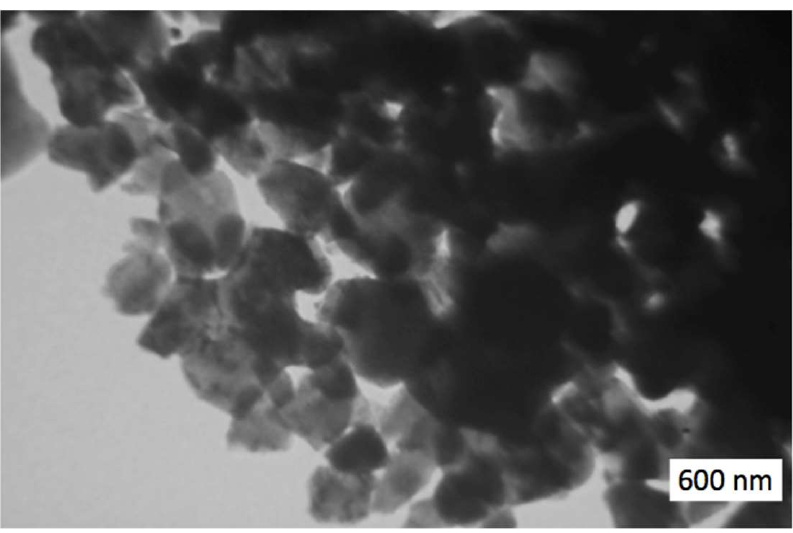
Figure 1. TEM image of the initial powder Al 2 O 3 —20 wt.% SiO 2 —10 wt.% ZrO 2 .